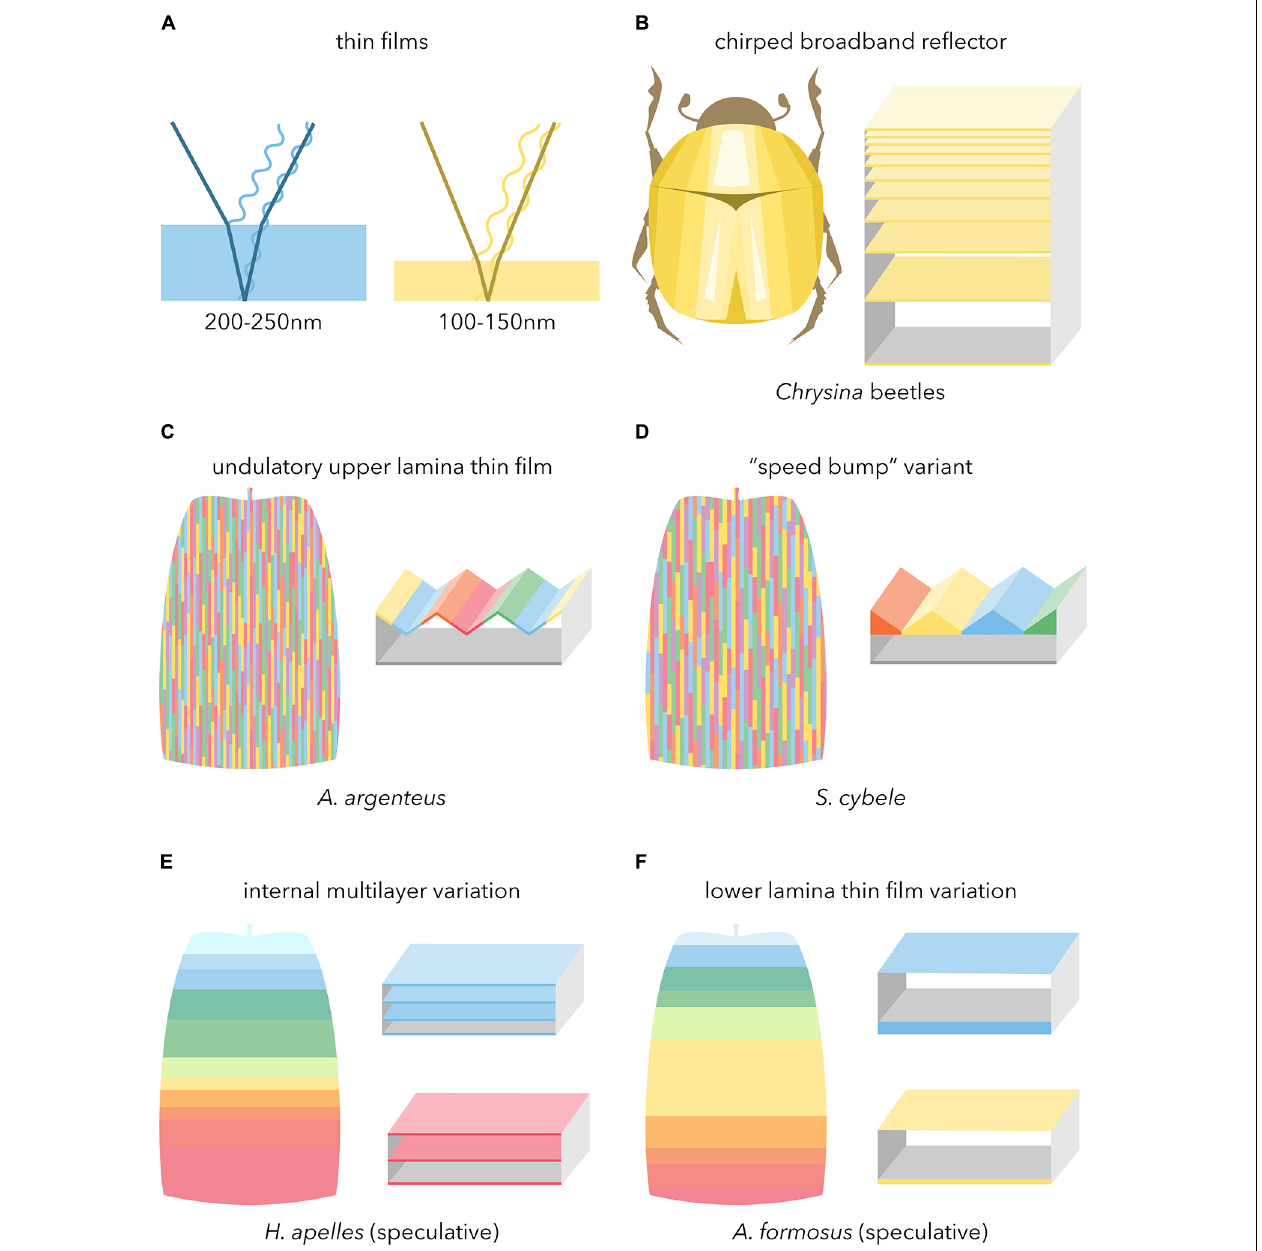
FIGURE 7 | Broadband reflectors underlying metallic iridescence in butterflies. Boxed schematics feature high-refractive index (filled) and low-refractive index (empty) materials. (A) Basic configuration of light reflection in simple chitinous thin-films. (B) Thick chirped stack reflector as observed in metallic beetles and butterfly pupae (after Neville, 1977). (C,D) Undulatory thin-films coupling a sawtoothed upper surface with an inner air layer, including the newly described variant from fritillary butterflies. Color array depicts the resulting rod-like mode of additive color mixing as observed under epi-illumination ( Figures 4G–H ’; see also Vukusic et al., 2008). (E,F) Speculative modes of proximo-distal additive color mixing as observed in a silvery lycaenid and golden riodinid (see main text for